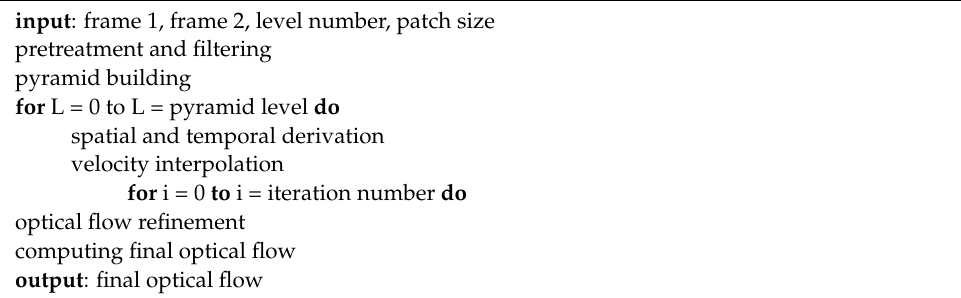
Algorithm 1 Pseudo code for min algorithm of pyramidal refinement